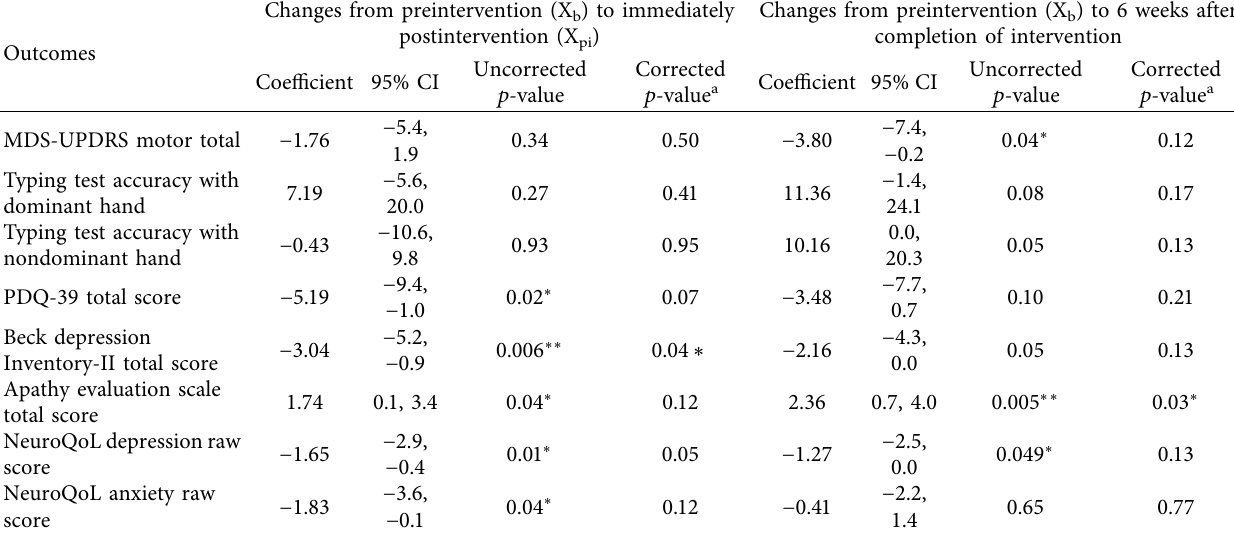
Table 3: Combined group analysis-effect of intervention immediately after and 6 weeks after completion of the intervention ( n � 26).